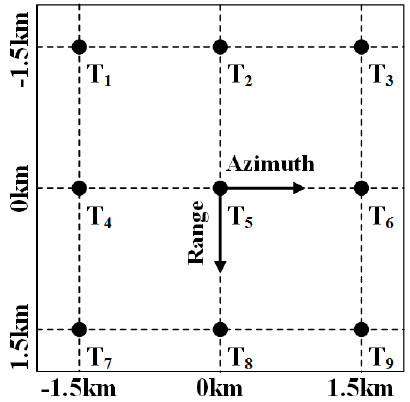
Figure 5. Distribution of point targets.